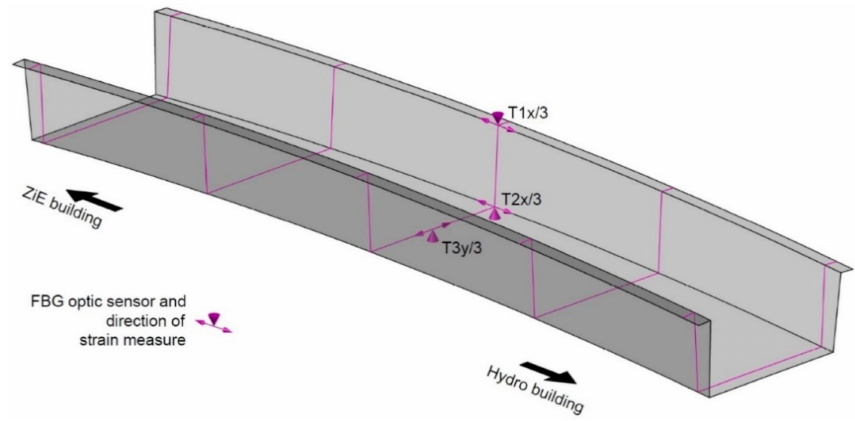
Figure 5. Location of FBG optic fiber sensors.